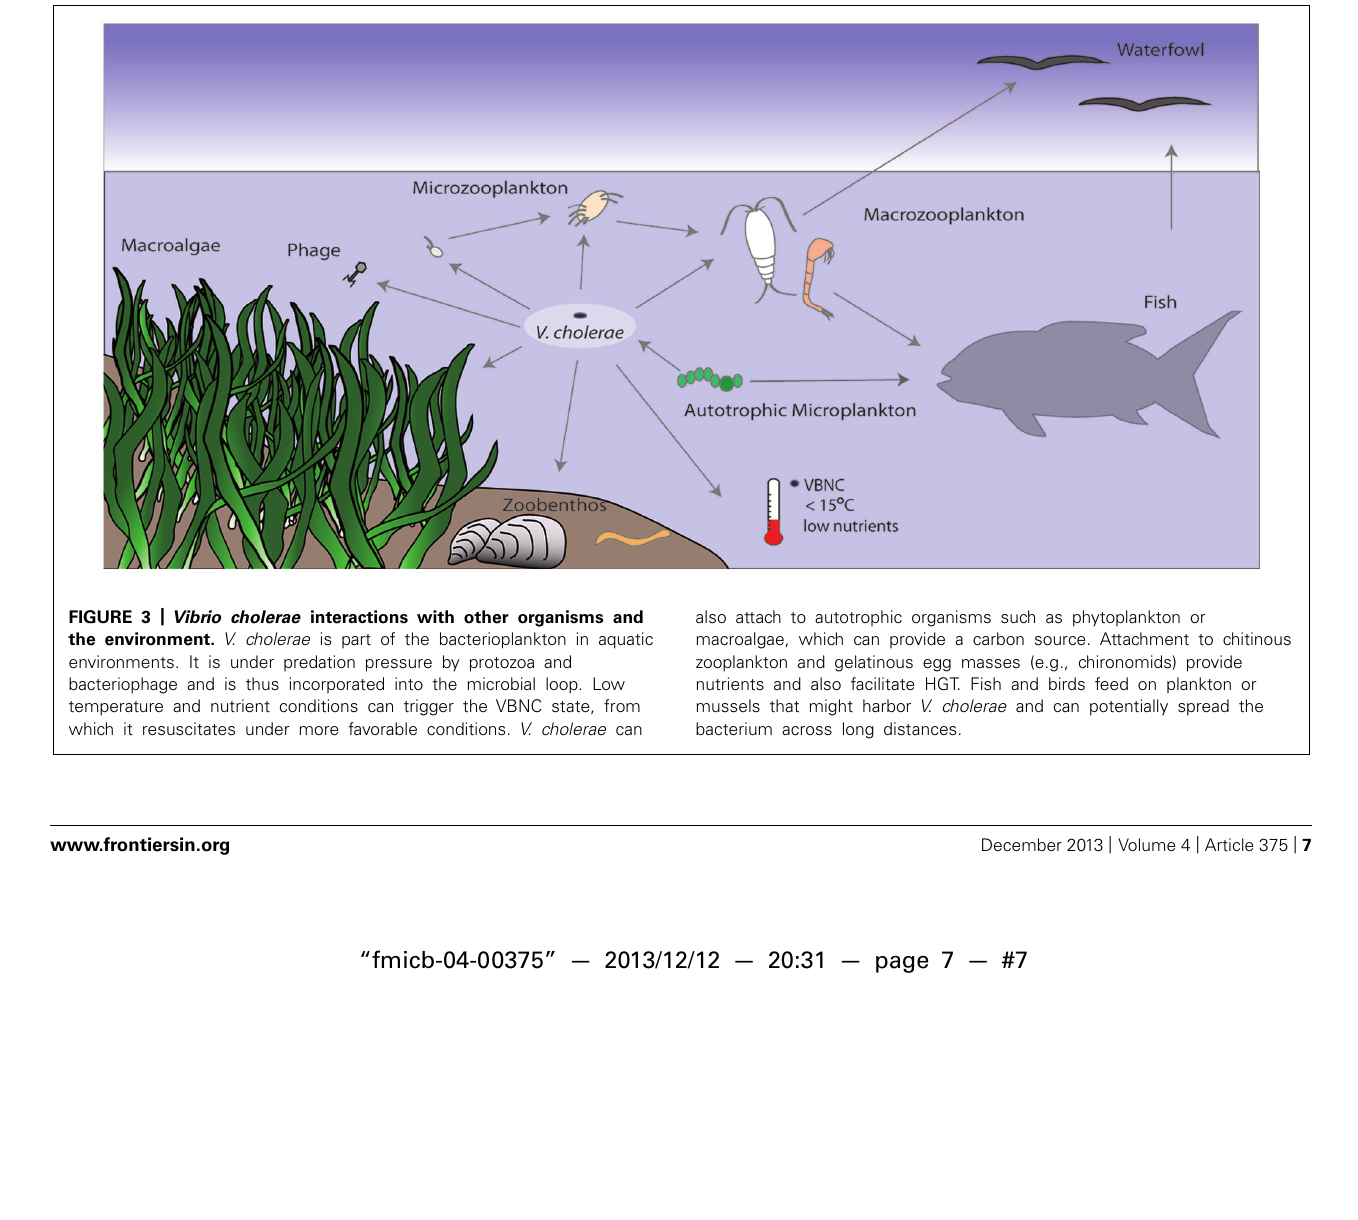
FIGURE 3 | Vibrio cholerae interactions with other organisms and the environment. V. cholerae is part of the bacterioplankton in aquatic environments. It is under predation pressure by protozoa and bacteriophage and is thus incorporated into the microbial loop. Low temperature and nutrient conditions can trigger the VBNC state, from which it resuscitates under more favorable conditions. V. cholerae can